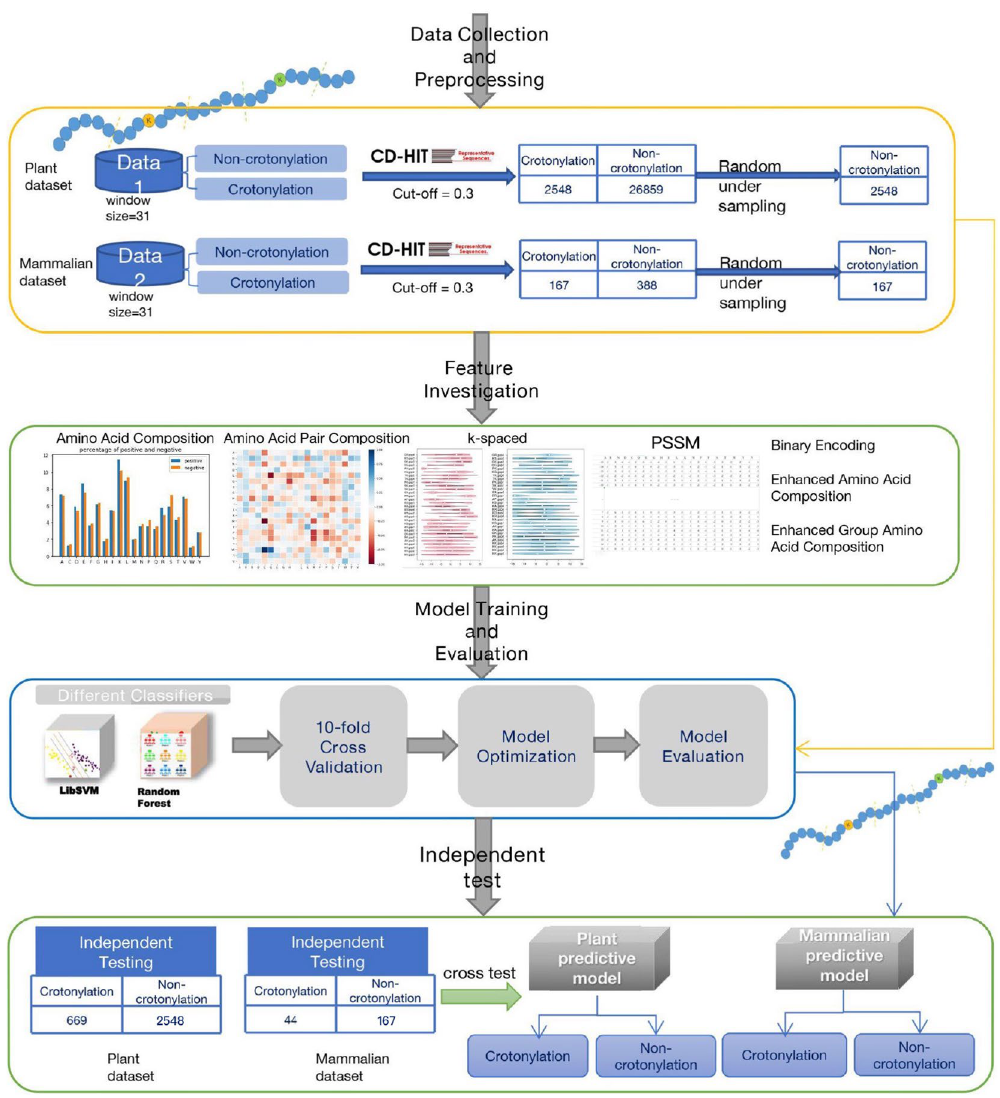
Figure 2. Flowchart of this paper. Four main steps contained: data collection and preprocessing, feature investigation, model training and evaluation and independent